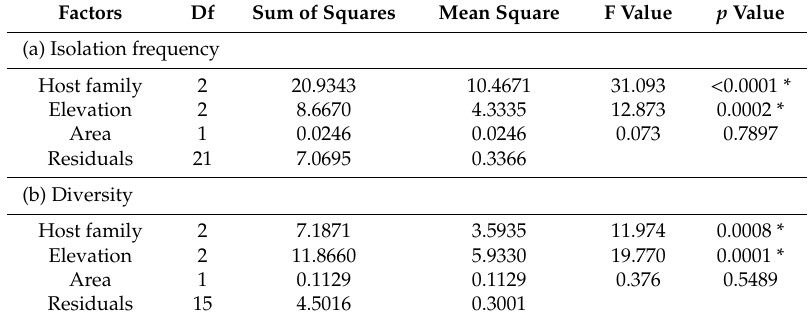
Figure 2. Isolation frequency and diversity differed as a function of elevation. ( a ) Isolation frequency. ( b ) Diversity. Residuals of ln-transformed isolation frequency or Fisher’s alpha were used to exclude the effect of host family. Tukey’s HSD test was used for the post hoc pairwise comparison. Lowercase letters in each graph indicate the significant differences tested by Tukey’s HSD test. Cycles are outliers. Table 2. ANOVA table of the multiple regression model for isolation frequency and diversity.